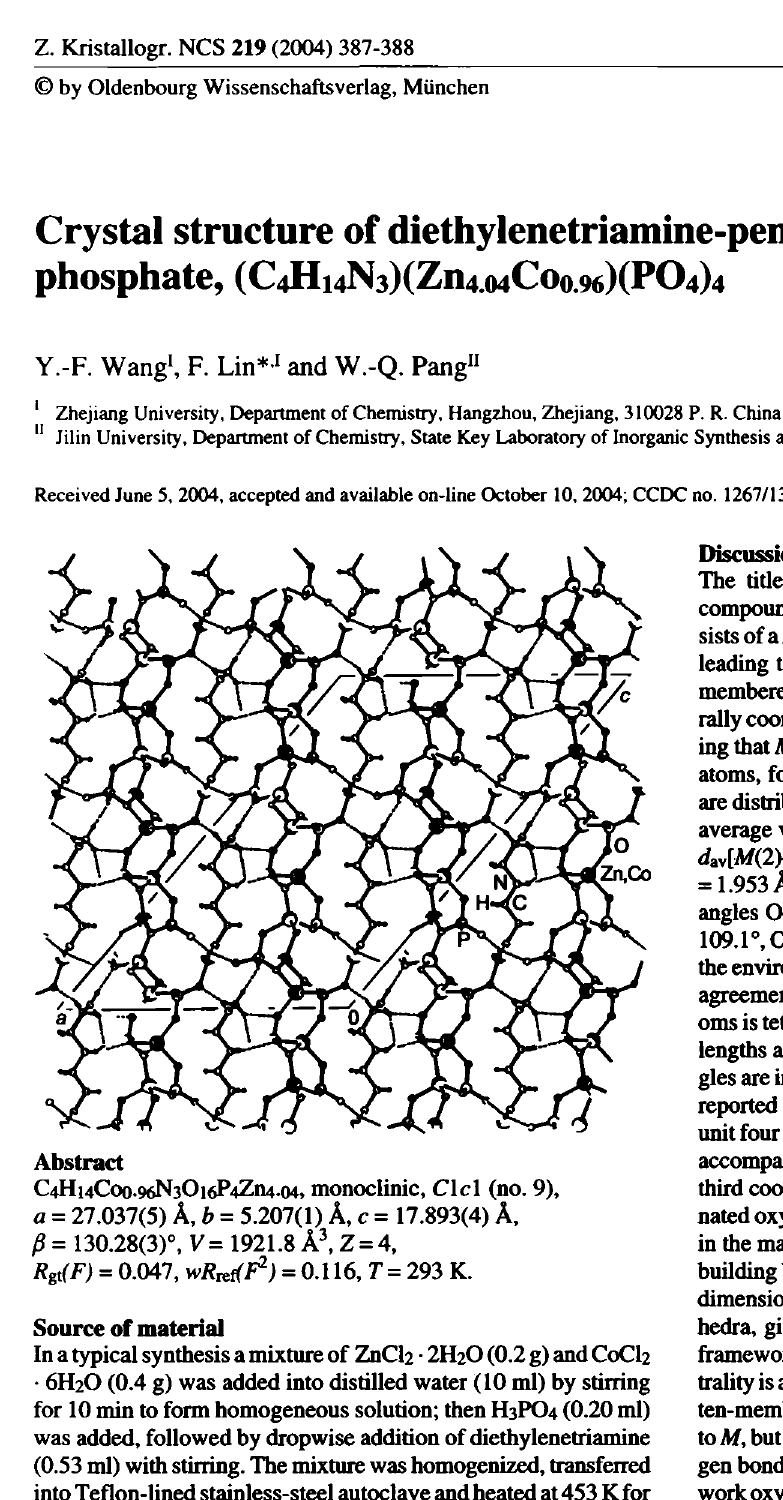
Table 1. Data collection and